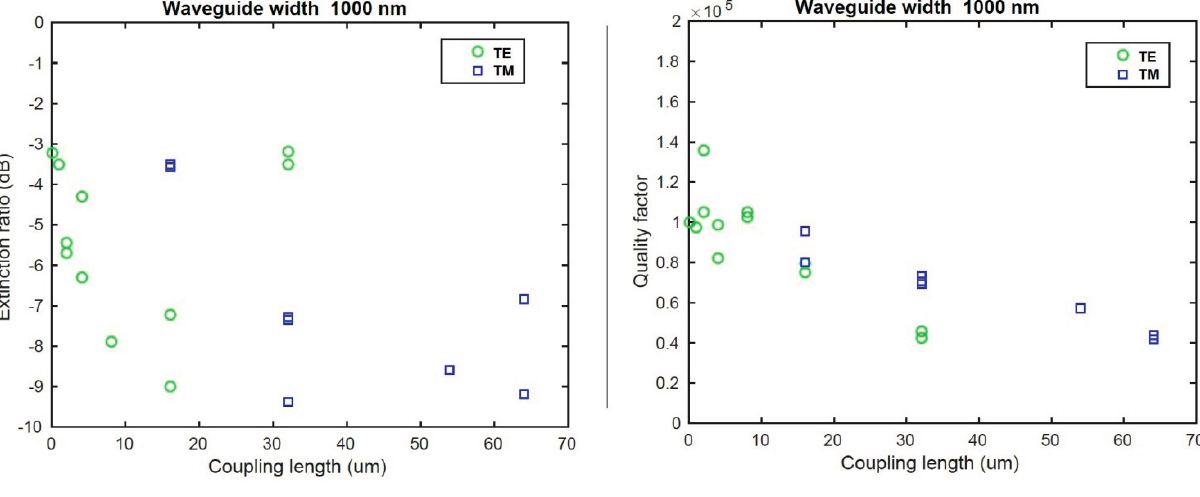
Figure 7. ( Left ) Extinction ratio analysis for the L5 sample; ( Right ) Quality factor analysis for the L5